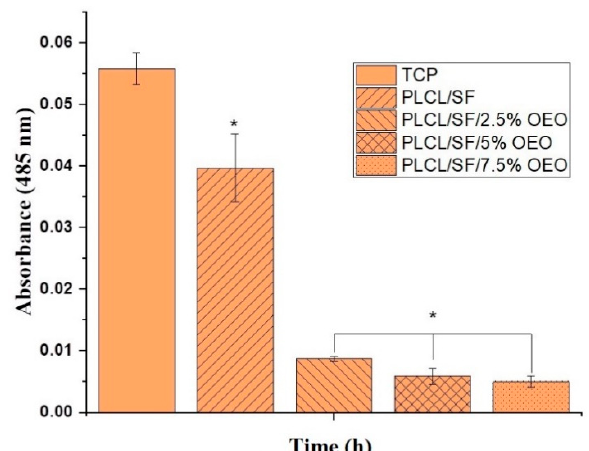
Figure 9. Cell counting Kit-8 (CCK-8) result of 4T1 cell line proliferation on NF membranes (* =significant difference; p < 0.05 n = 3).